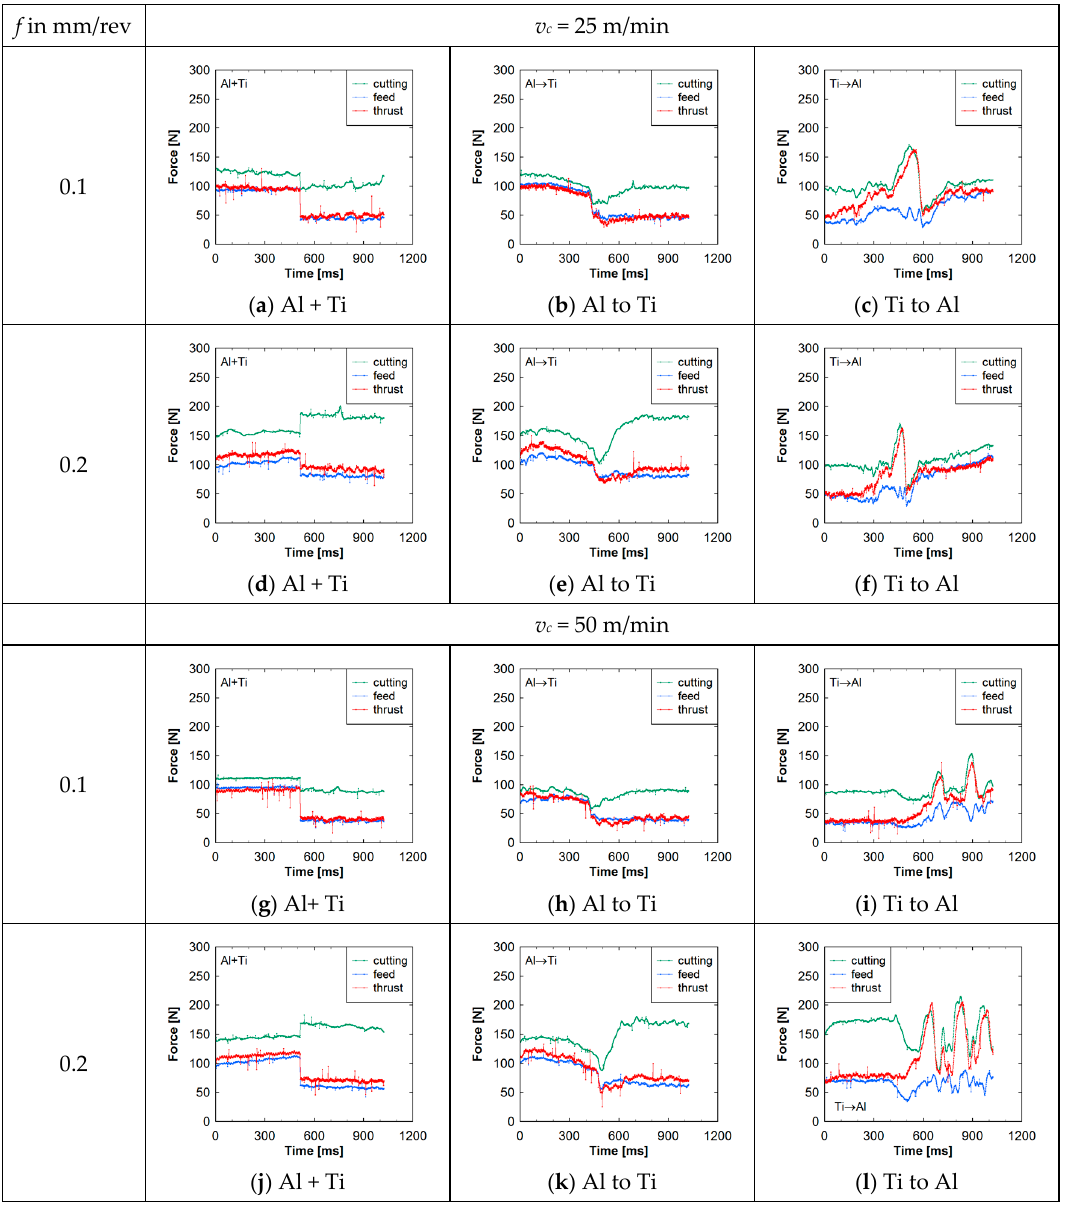
Figure 6. Machining forces underlying Al − Ti.